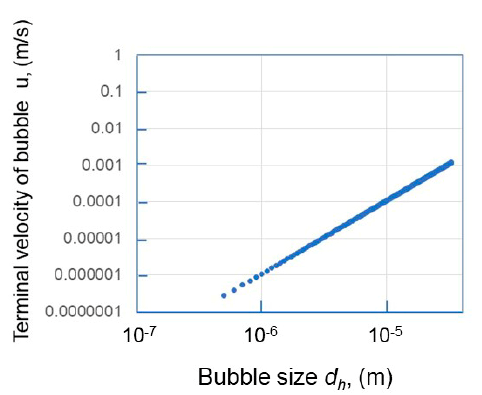
Figure 12. Relationship between the terminal velocity of a floating bubble and bubble size.